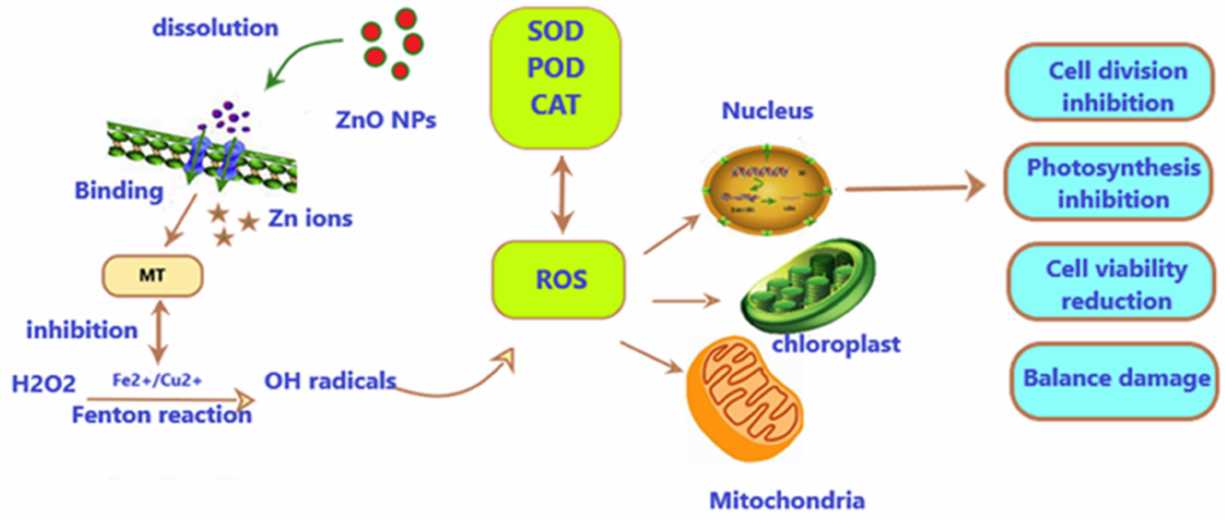
Figure 4. The toxicity of ZnO-NPs on algae